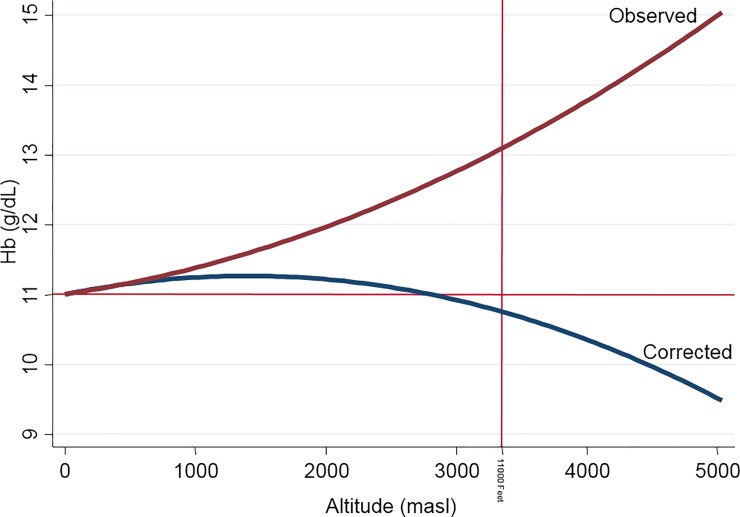
Hemoglobin trends according to observed and WHO altitude-corrected values.Red line parallel to X axis represents the 11 g/dL anemia threshold and the red line parallel to Y axis the 11000 feet boundary of WHO/CDC altitude-correction factor equation.